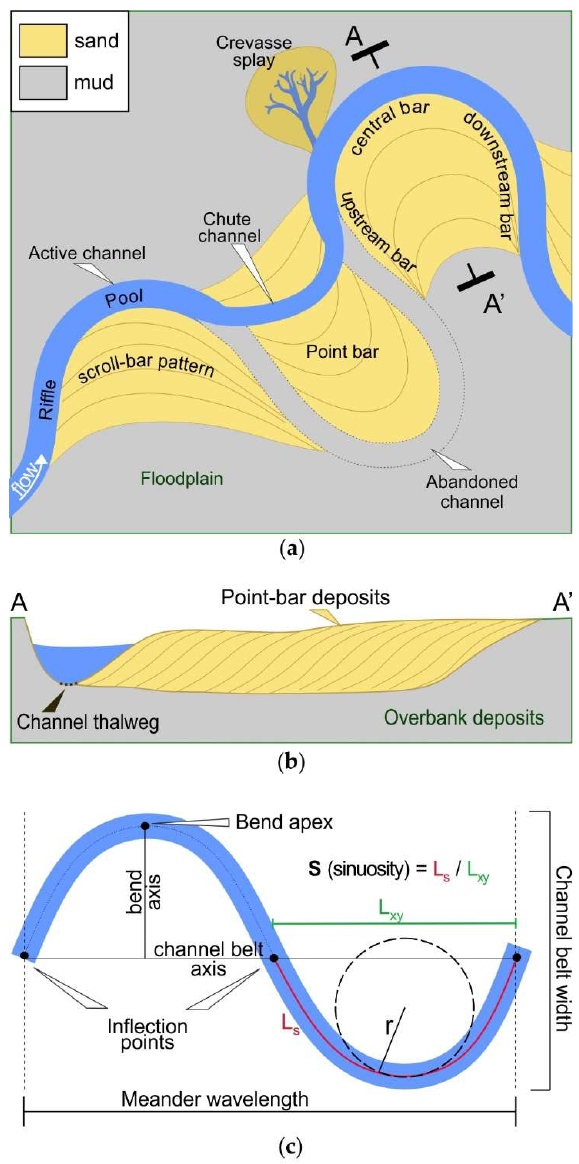
Figure 3. Descriptive terminology for fluvial meanders and related deposits: ( a ) alluvial plain morphological elements, ( b ) point-bar deposits and ( c ) meander-belt morphometry.